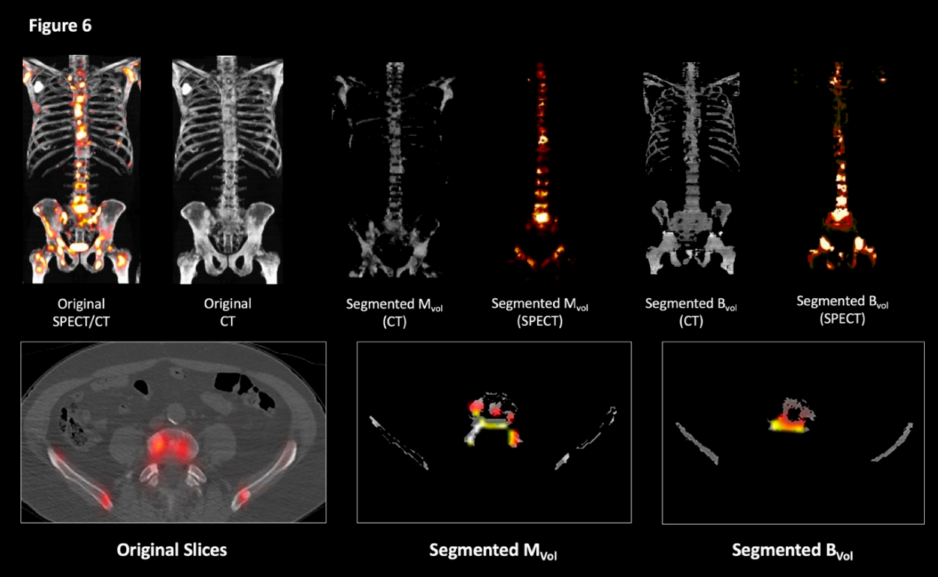
Figure 6. Examples of the segmentation output. Three-dimensional maximum intensity projections representations (top panels) and transaxial views (bottom panels) of the original images (left) and of the processed imaging outputs (center and